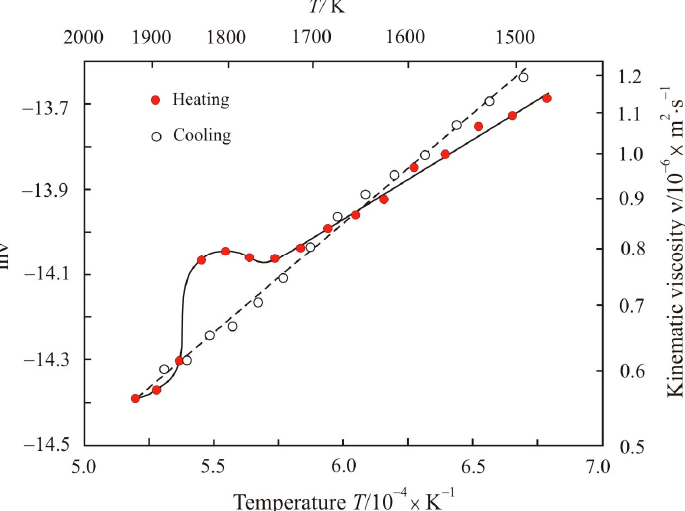
Figure 5. Kinematic viscosity in natural logarithmic scale ln ν as a function of the inverse absolute temperature 10 4 × T − 1 upon heating to the maximum temperature 1920 K and cooling the Fe 84.5 Cu 0.6 Nb 0.5 Si 1.5 B 8.6 P 4 C 0.3 melt.